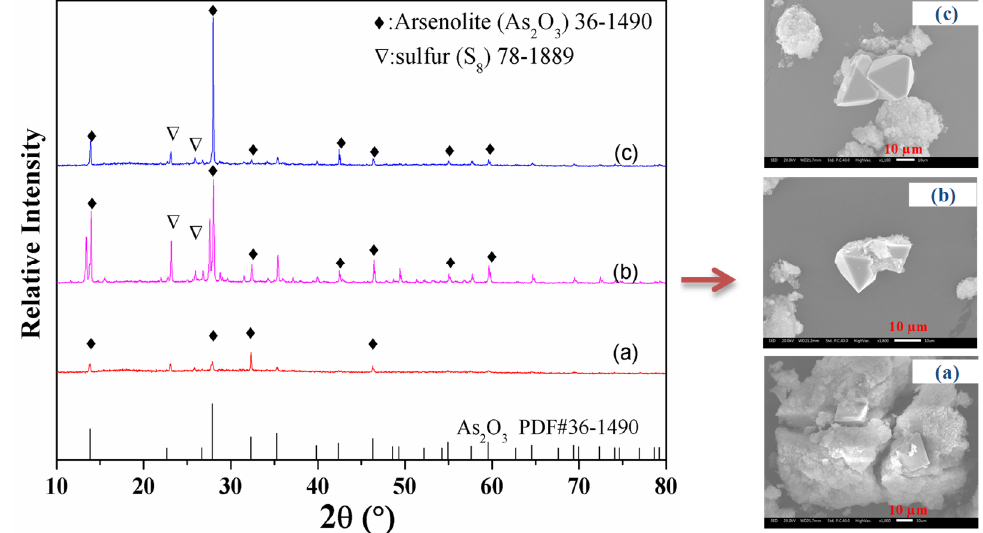
Figure 9. XRD and SEM images of the ASS after simulated storage: ( a ) simulated storage in vacuum at 30 °C for 48 h; ( b ) simulated storage in vacuum at 60 °C for 48 h; ( c ) simulated storage in air at 60 °C for 48 h.